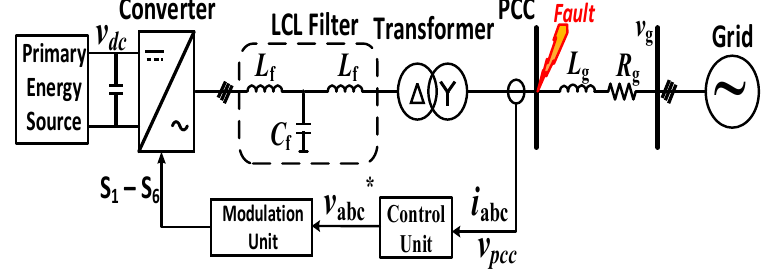
Figure 2. Schematic diagram of the network under consideration.